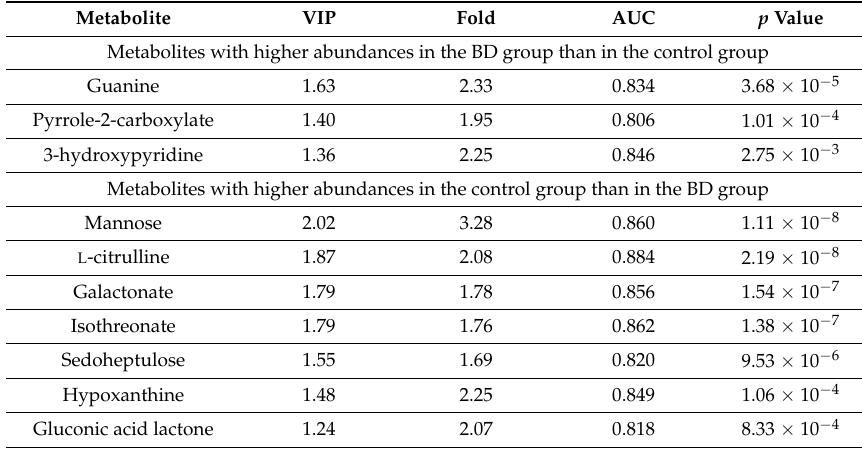
Table 1. VIP, fold change, AUC, and p values of urine metabolites to be used as potential biomarkers for discrimination of patients with Behcet’s disease from healthy